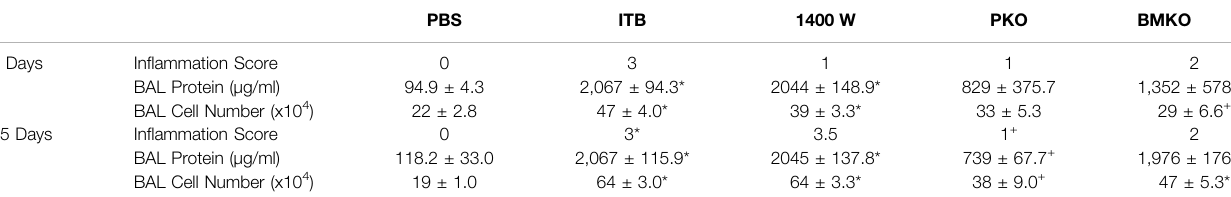
TABLE 1 | In fl ammation and injury were assessed following instillation of PBS and bleomycin. In fl ammation score was blindly assigned based on histological assessment. Protein and total cell number was measured in bronchoalveolar lavage fl uid. ( n = 3 – 7 per group) * p < 0.05 compared to PBS, + p < 0.05 compared to ITB.